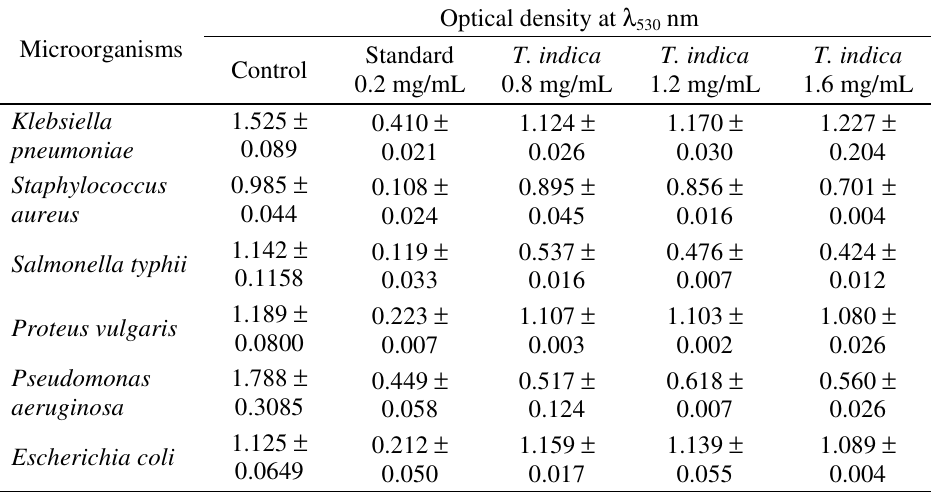
Table 4. Evaluation of the antimicrobial bioassay of ethanolic extract of Tylophora indica (Burm.f.)